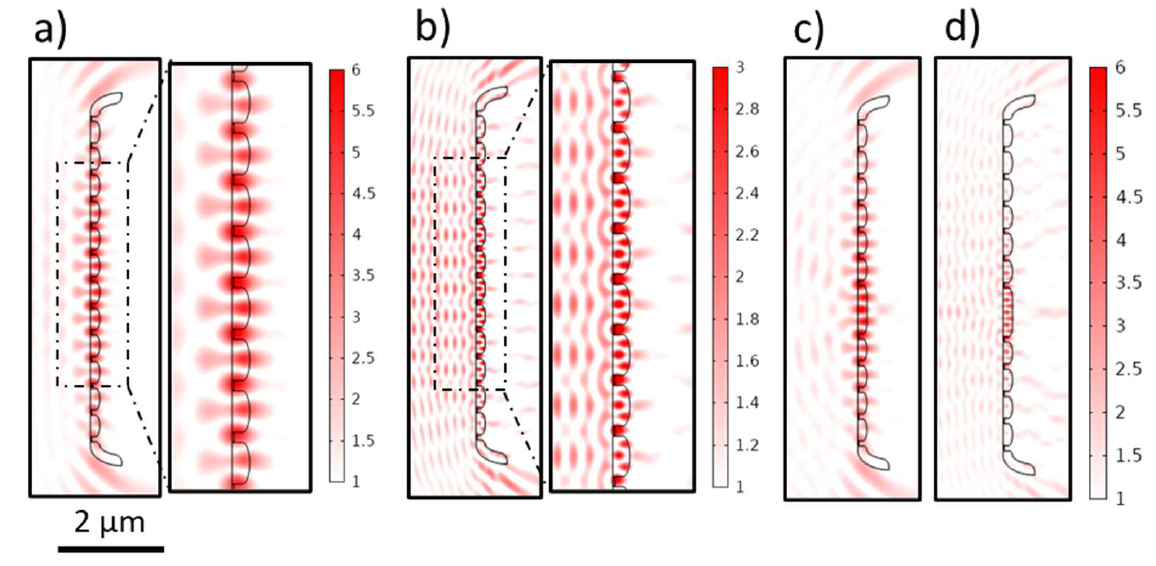
Figure 10. Grid-coupled GMR of CS long,4 at the maxima of zero ( a ) and first modes ( b ) and of CS long,4* at the maxima of zero ( c ) and first modes ( d ) in air. The E Norm, GMR is 6.31 ( a ), 4.01 ( b ), 6.67 ( c ), and 5.17 ( d ) V/m at λ vacc,GMR 553 nm, 303 nm, 559 nm, and 307 nm, respectively. The color code emphasizes the E Norm enhancement in red ( E Norm > 1 V/m) while both the E input and the E Norm reduction are in white ( E Norm ≤ 1 V/m), not emphasized.